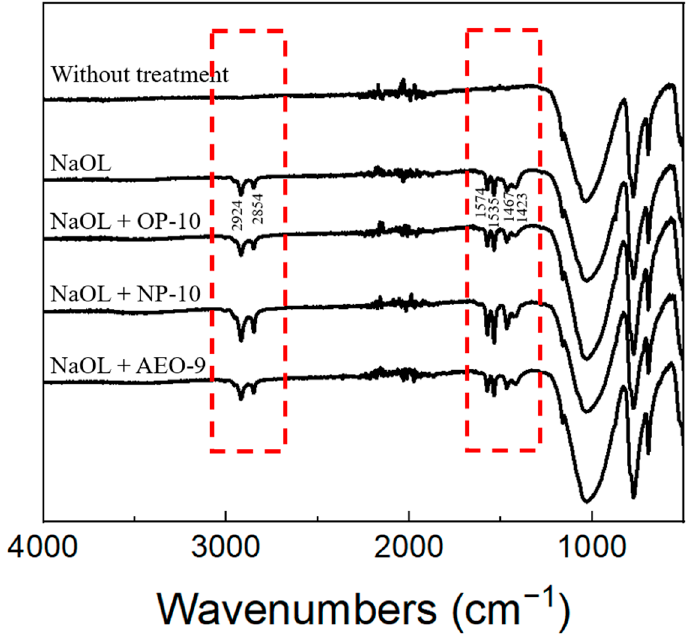
Figure 3. FTIR spectra of pure quartz and activated quartz conditioned with NaOL, NaOL + OP ‐ 10, NaOL + NP ‐ 10 and NaOL + AEO ‐ 9.